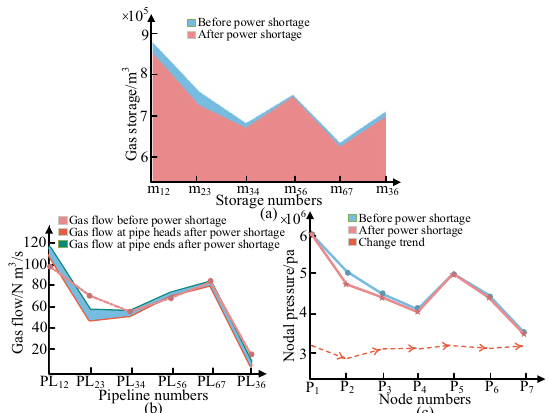
Fig. 7 The network conditions with the power shortages at L 1 Fig. 8 The network conditions with the power shortages at L 2 Fig. 9 The network conditions with the power shortages at L